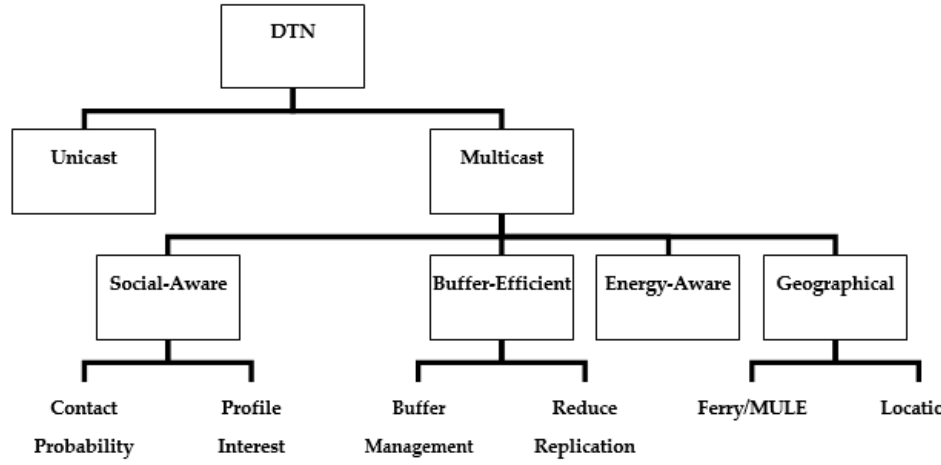
Figure 4. Classification of DTN multicast routing strategies.